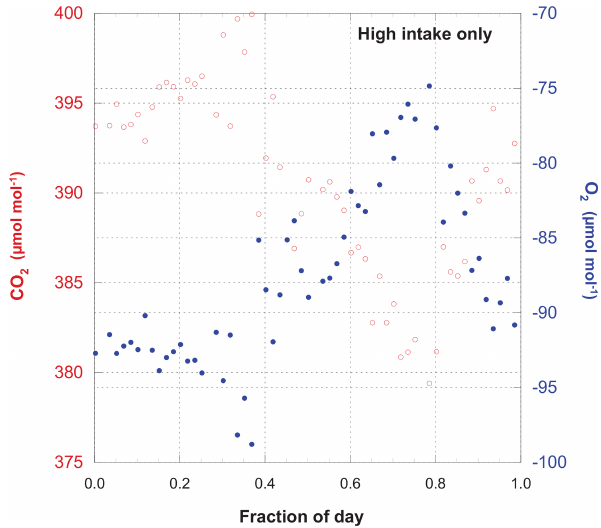
Figure 4. A detailed look at Fig. 3. CO 2 and O 2 measured from the high intake on 29 September 2006. This is simply one example of the diel cycle of these species. Note the strict inverse variation in O 2 and CO 2 , even when there are large deviations from a smooth temporal